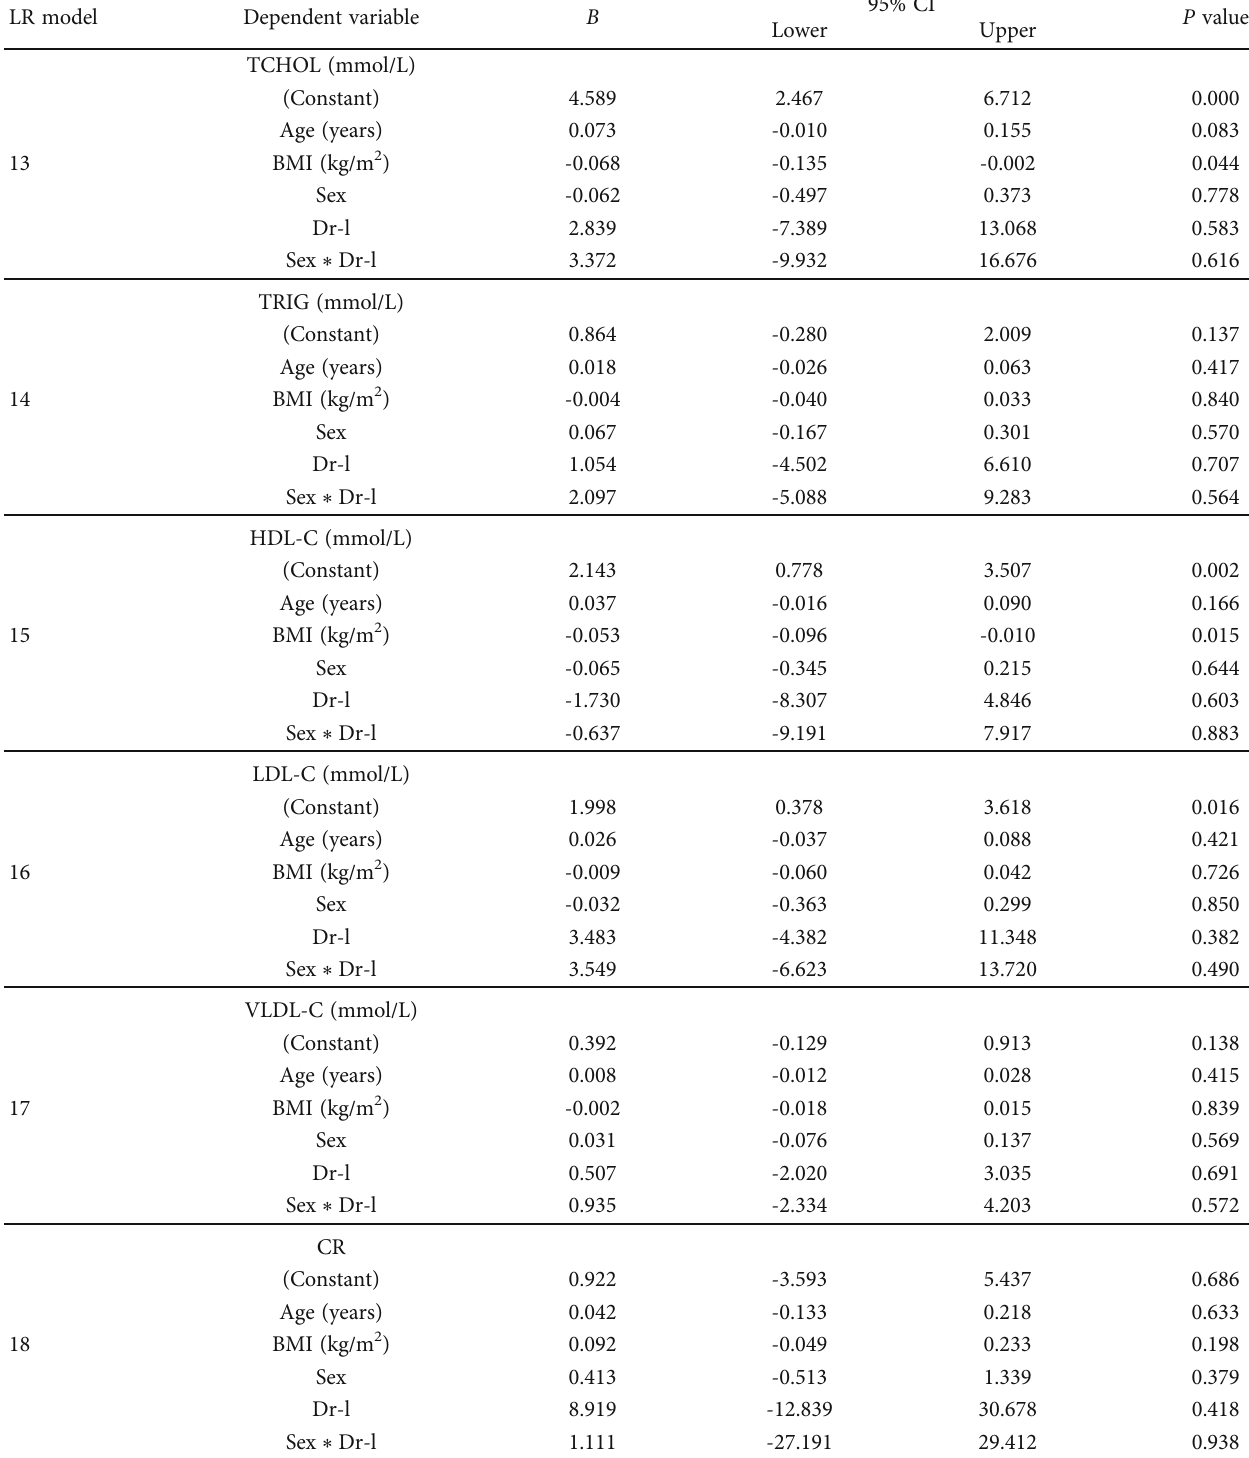
Table 4: Interactions between sex and the Dr-l on fasting plasma lipid